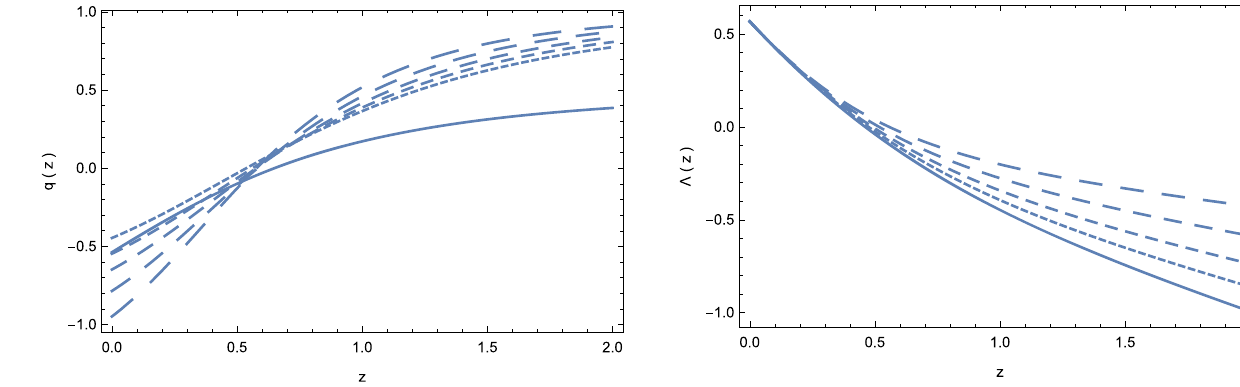
(cid:11) (cid:12) ˜ Q , ˜ T = α ˜ Q + β ˜ T